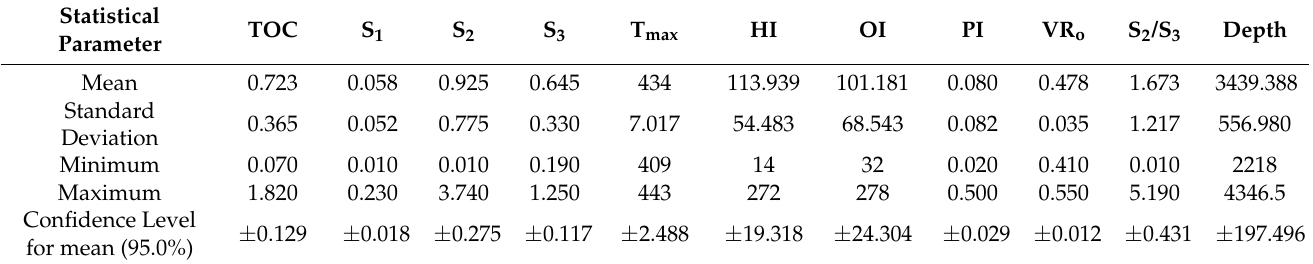
Table 2. Statistical parameters for all characters.